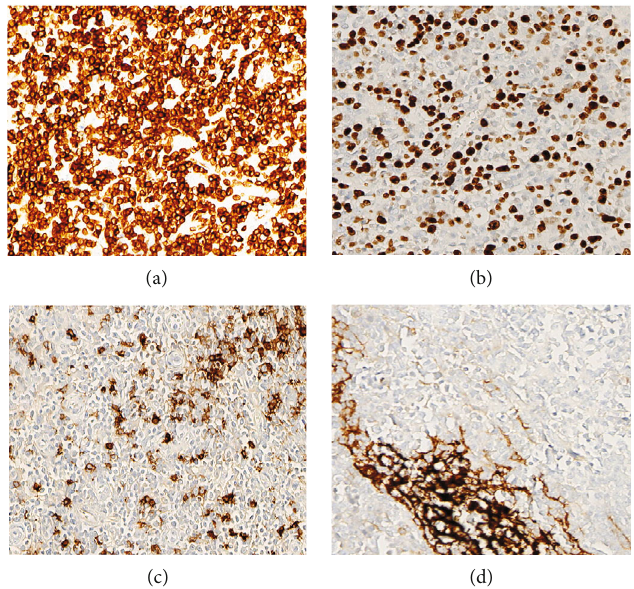
Figure 4: Immunohistochemical results (EnVision method, original magni fi cation 200x) of peripheral T-cell lymphoma: (a, b) CD3 and Ki67 expression on oncocytes; (c, d) CD20- and CD23-negative